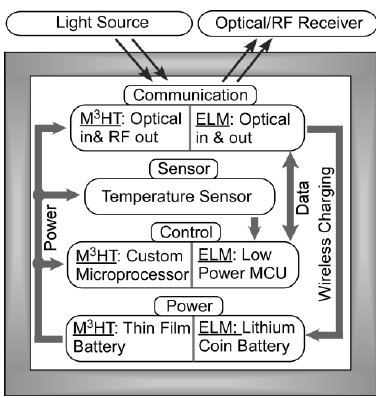
Figure 3. Functional block diagram of both the M 3 HT and ELM systems. Both systems consist of four modules: communication, sensor, control and power. Both systems are powered by a battery that is optically recharged.